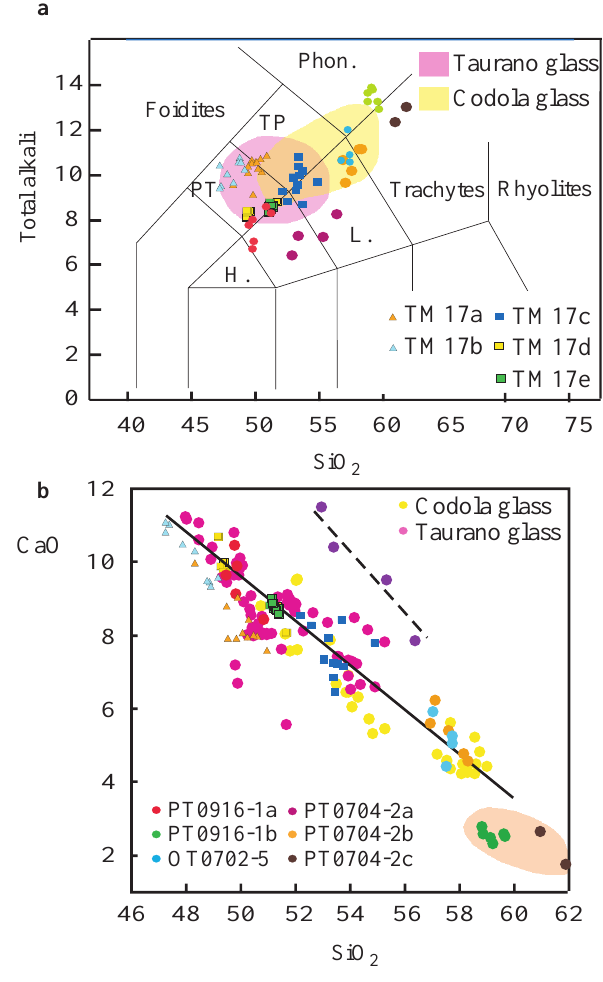
Fig. 6. (a) Total alkali vs. silica diagram for the different groups of OT0702-5 (pale blue dots), PT09-16 (red and green dots), PT0704- 2 (purple, orange and black dots); (b) CaO vs. SiO 2 diagram for the same groups of Fig. 5a. Compositonal fields of proximal deposits of Taurano and Codola eruptions are shown, together with analy- ses of some TM17 tephra layers from Lago Grande di Monticchio succession (Wulf et al.,